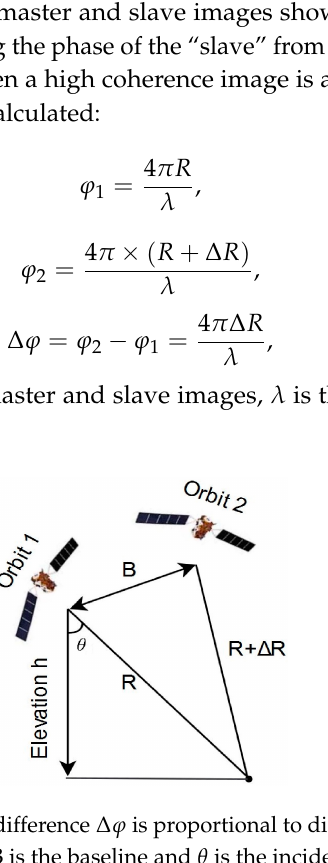
is proportional to distance difference divided . The B is the baseline and is the incidence angle. ∆𝛥𝛥 ∆𝜋𝜋 𝜆𝜆 𝜃𝜃